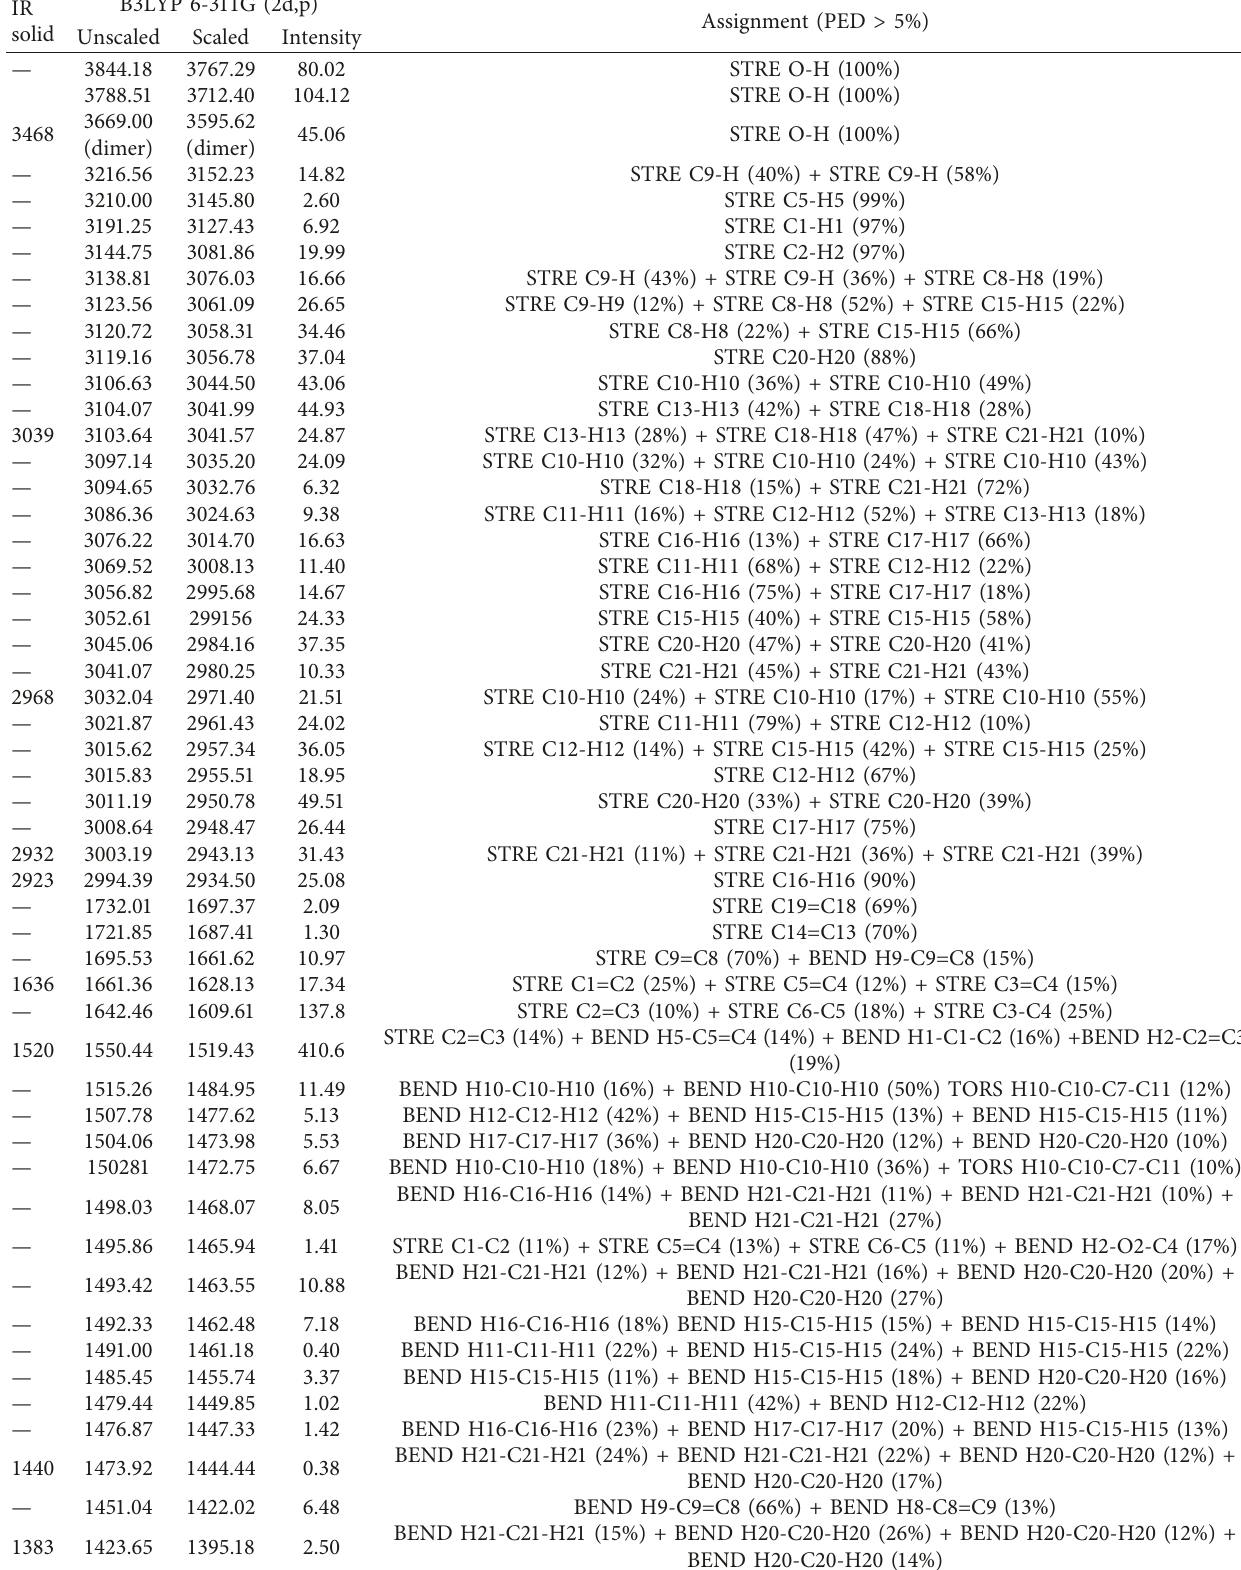
Table 2: Experimental and calculated wavenumbers (cm − 1 ) and assignments for